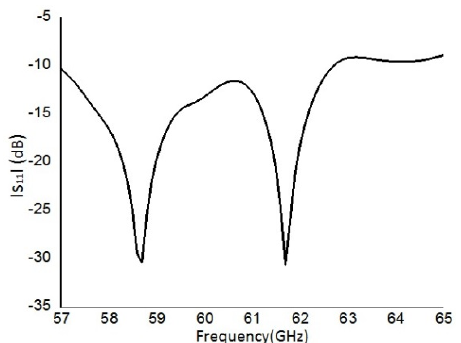
Figure 10. Simulated S-parameters curves versus frequency of the proposed mmWave 5G antenna array.